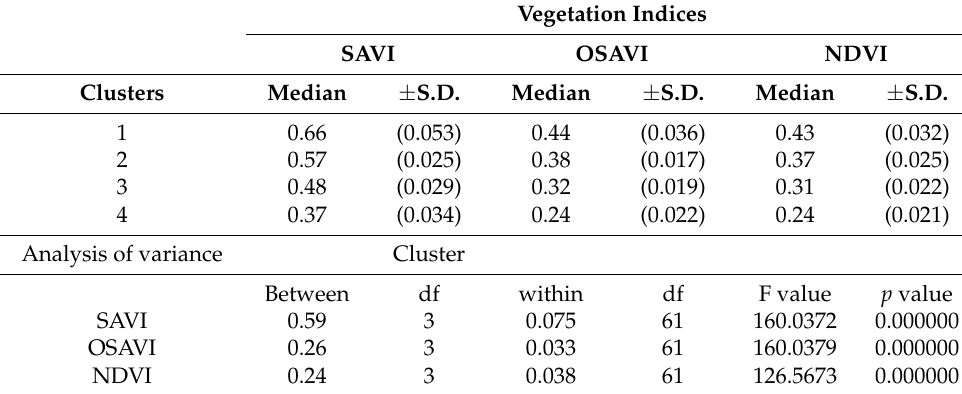
Table 3. Vegetation indices’ (VIs) median values, standard deviations, and analysis of variance of clusters identified by Ward’s cluster method at seedling stage. The median values are assumed as a measure of central tendency in case of not symmetrical data distribution. Vegetation Indices SAVI